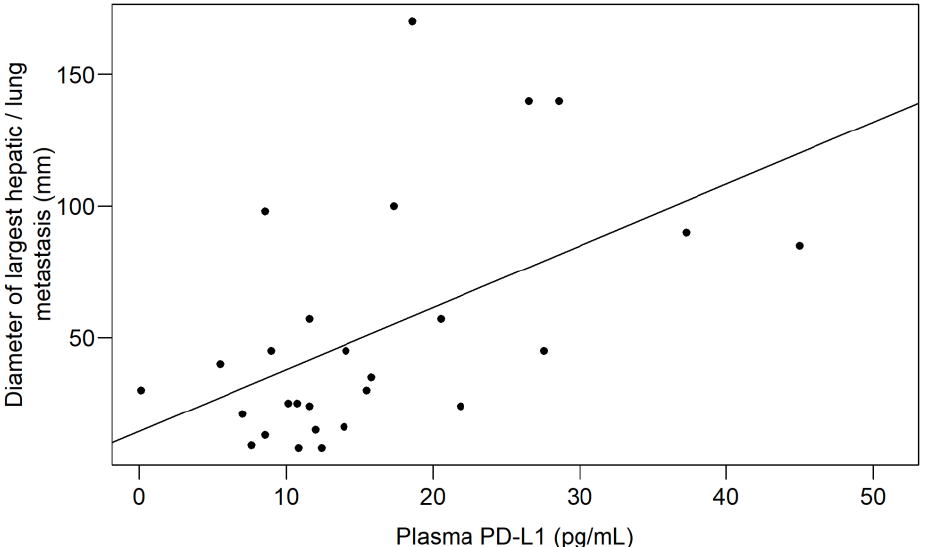
Figure 3. A strong association was found between plasma PD-L1 levels and the diameter of the largest hepatic/lung metastases ( p = 0.0059). PD-L1: programmed death-ligand 1.